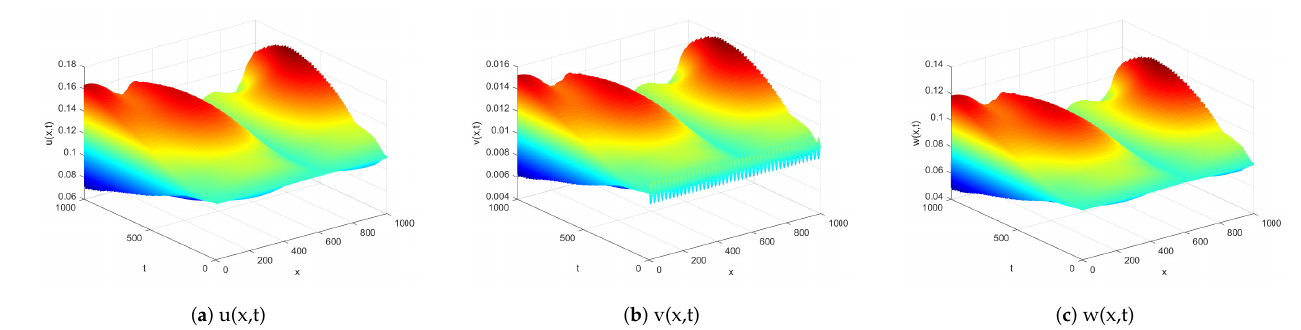
Figure 6. ( u p ( t ), v p ( t ), w p ( t )) becomes diffusion-induced unstable, and the emerging spatiotemporal patterns are observed.